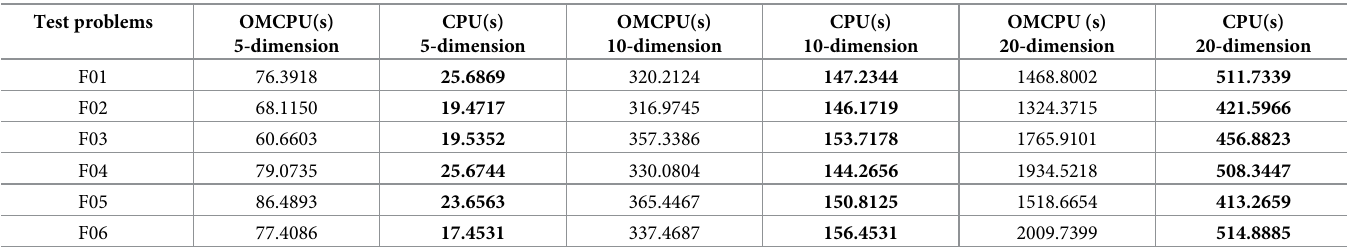
Table 8. Comparison of CUP time on 5, 10 and 20-dimensional test problems. Test